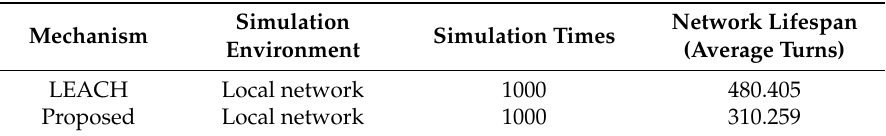
Table 2. Network lifespan